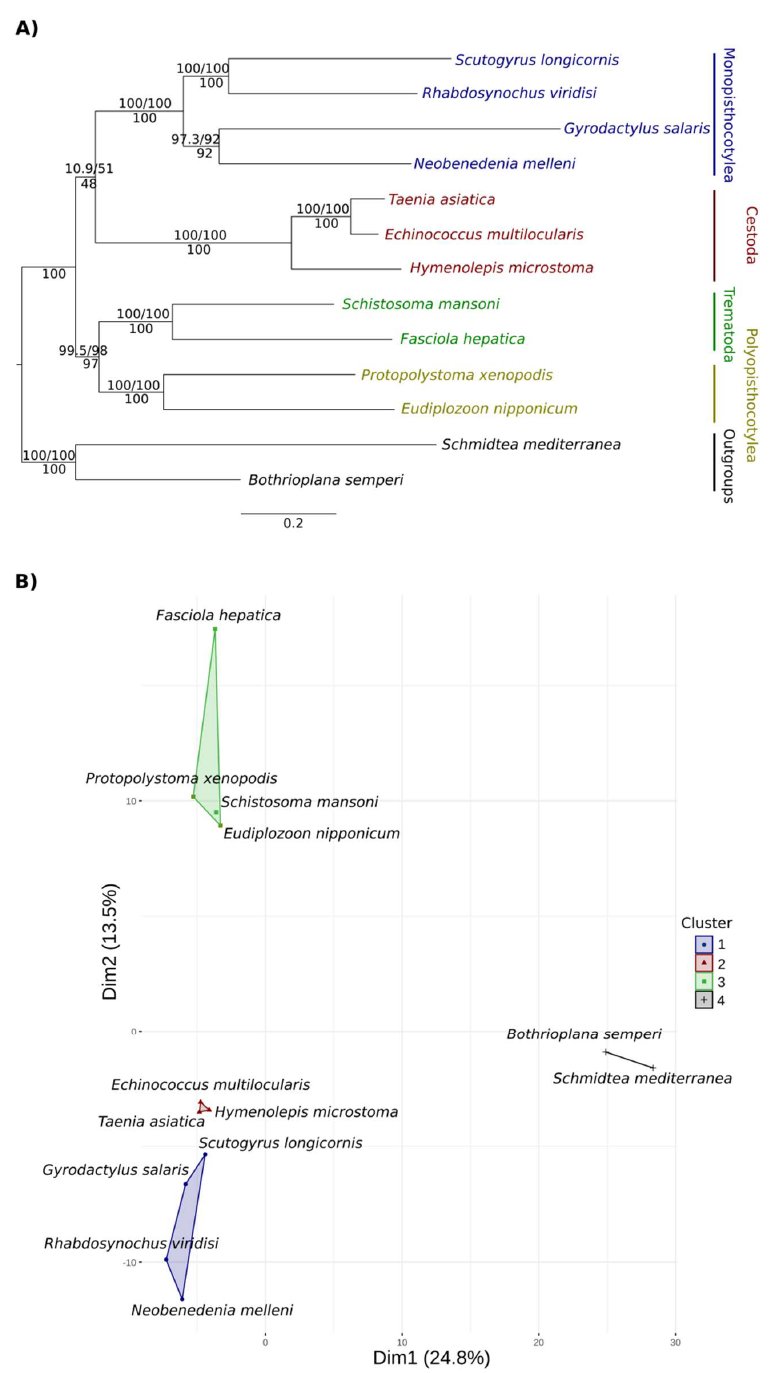
Figure 4. Peptidases and inhibitors of 13 platyhelminth species analysed. ( A ) Phylogenetic tree with values above representing SH-aLRT support (%)/ultrafast bootstrap support (%) and below repre- senting Maximum Likelihood rapid bootstrap support. The free-living platyhelminths Bothrioplana semperi , belonging to the order Bothrioplanida, and Schmidtea mediterranea , belonging to the order Tricladida, were used as outgroups. ( B ) Formation of clusters according to their peptidases and inhibitors OGs using hierarchical grouping analysis in principal components.